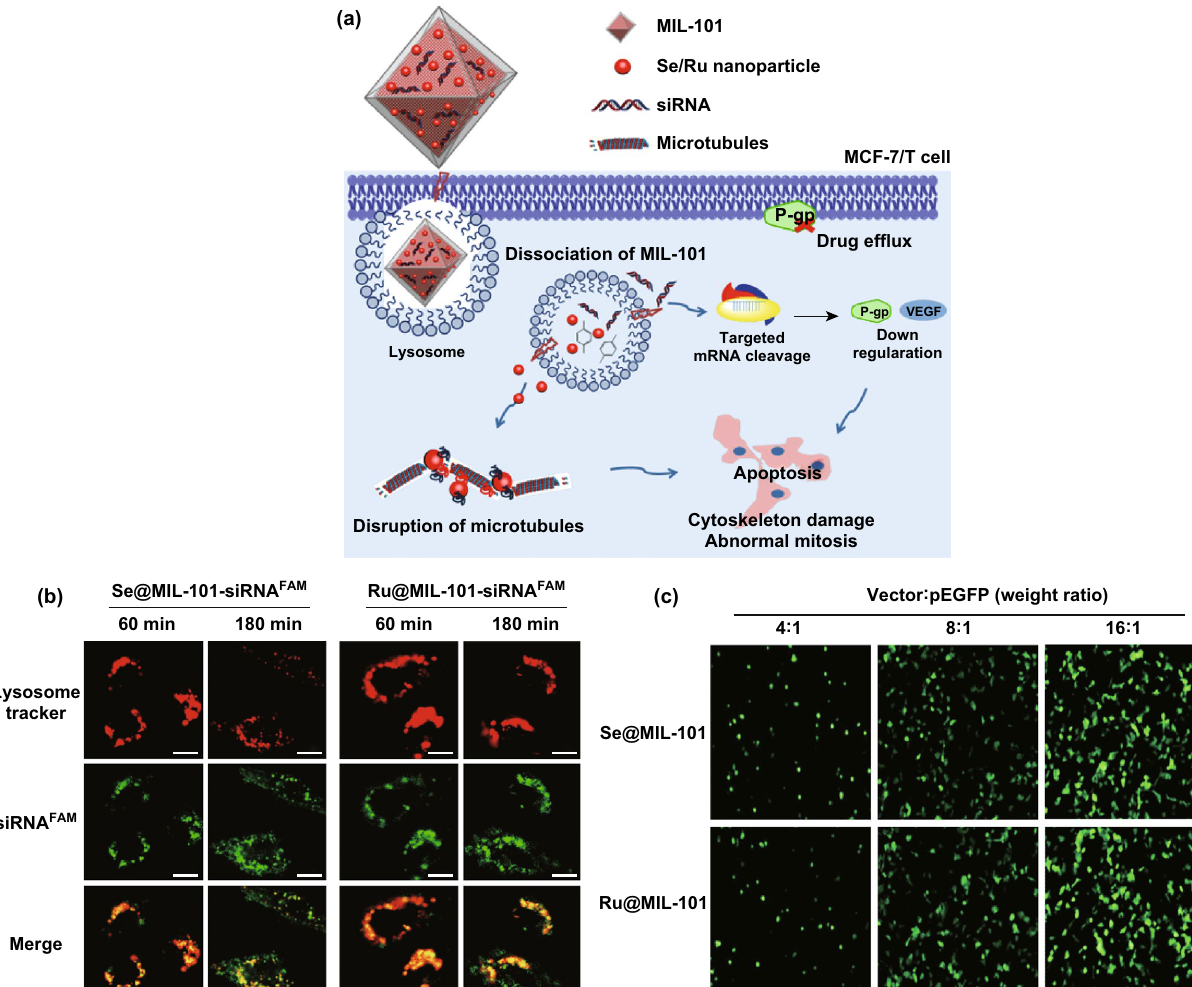
Fig. 11 a Mechanism of Se/Ru nanoparticles and siRNA co-delivery by MIL-101 for the reversal of drug resistance and induced apoptosis by the disruption of microtubule in MCF-7/T (Taxol-resistant) cancer cells. b Time-dependent confocal microscopy of siRNA escaped from endosomes in MCF-7/T cells. Scale bar: 5 μm. c Fluorescence microscope images of MCF-7/T cells transfected by Se@MIL-101 and Ru@MIL- 101 for 24 h. Reproduced with permission from Ref. [130]. Copyright 2017, American Chemical